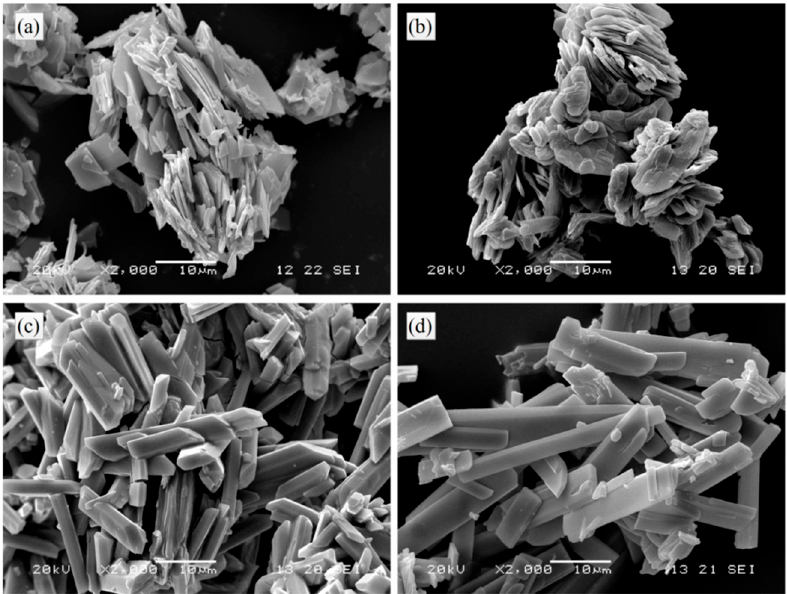
Figure 8. SEM images of lead citrate crystals obtained under different synthesis conditions. ( a ) Initial temperature: 35 °C, molar ratio of CA/SC: 0.92; ( b ) Initial temperature: 35 °C, molar ratio of CA/SC: 0; ( c ) Initial temperature: 95 °C, molar ratio of CA/SC: 0; ( d ) Initial temperature: 95 °C, molar ratio of CA/SC: 0.92.